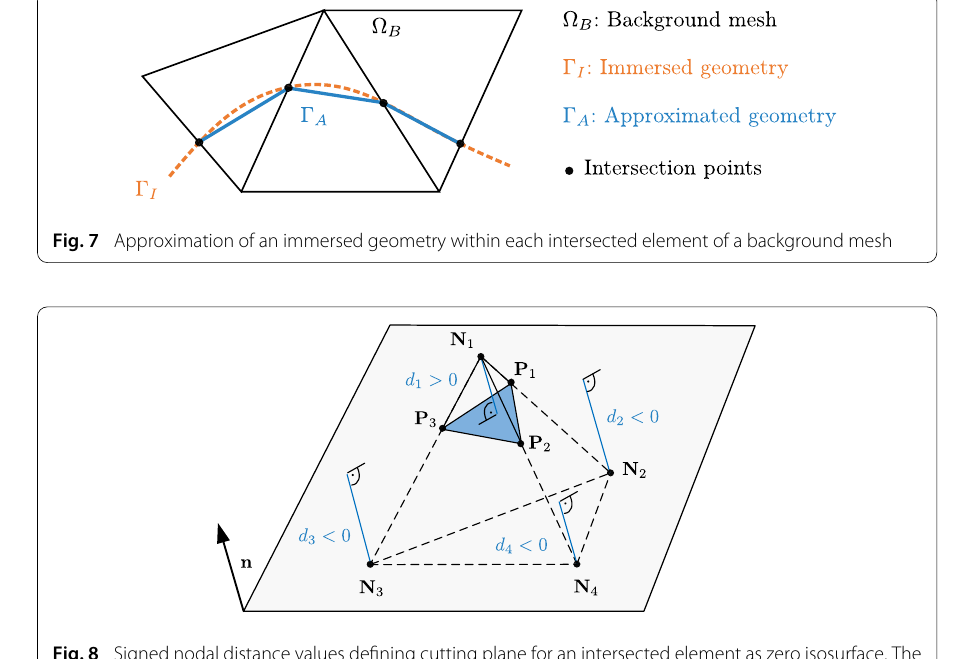
Fig. 8 Signed nodal distance values defining cutting plane for an intersected element as zero isosurface. The cutting plane locally approximates the immersed geometry (blue